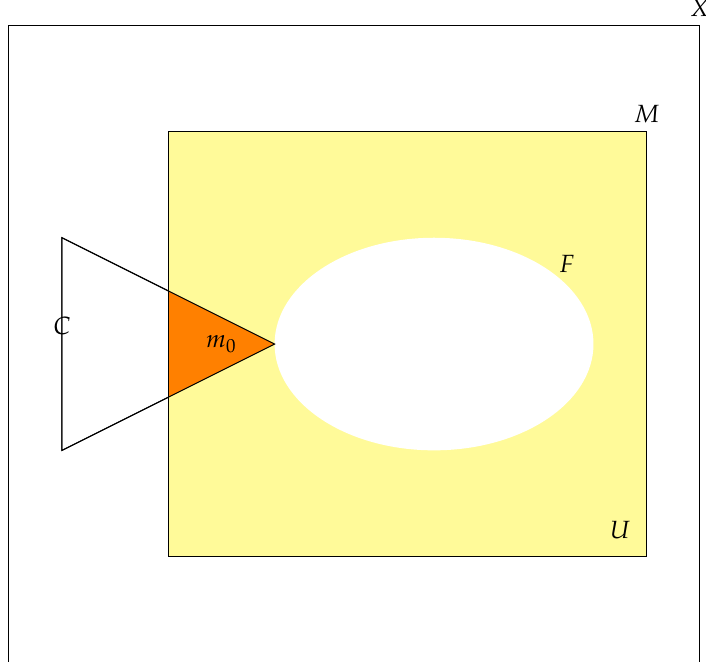
Figure 5. In yellow, elements in M with a unique (positive) price. In orange, elements in C with a unique (positive) price. In white, elements in F with a unique (negative or null) price. Source: Own